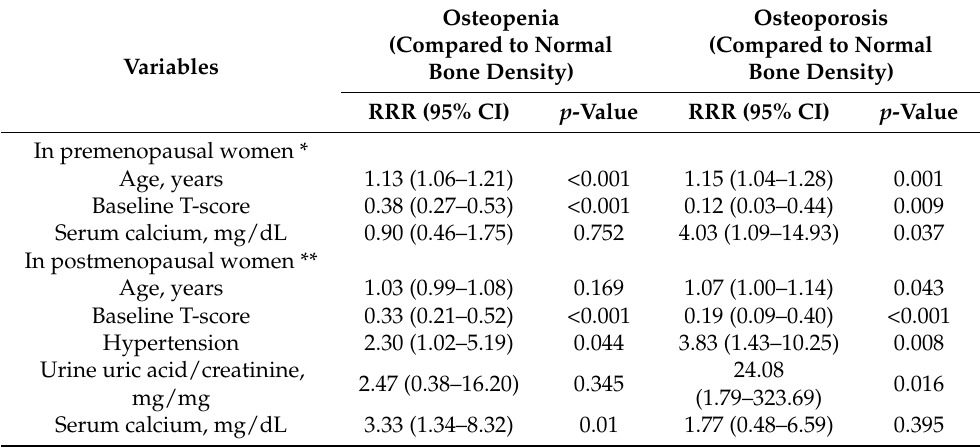
Table 2. The relative risk of developing osteopenia or osteoporosis compared to maintaining normal bone density according to each risk factor analyzed by multinomial multivariable logistic regression. Osteopenia (Compared to Normal Variables Bone Density)